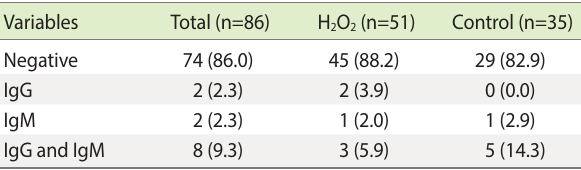
Table 3. Results of tests on family members Variables